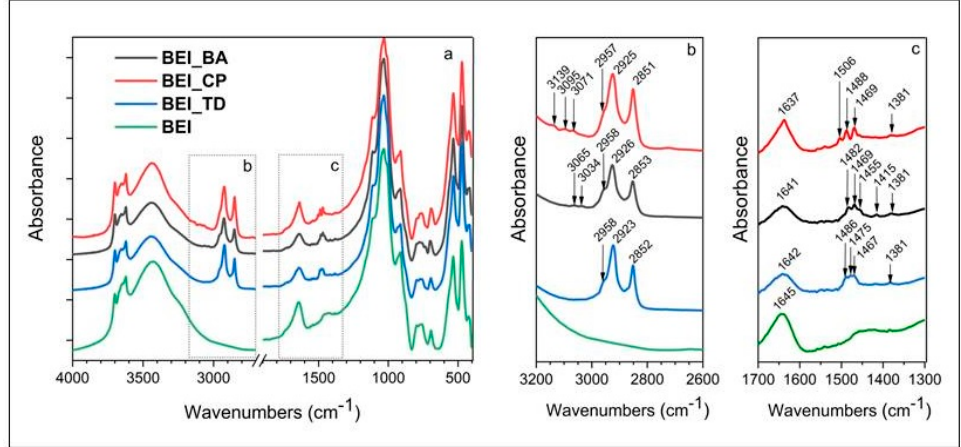
Figure 6. IR spectra of BEI_BA, BEI_CP, BEI_TD and BEI: ( a ) in the whole middle IR area, ( b ) from 3200–2600 cm − 1 and ( c ) from 3200–2600 cm − 1. 3200–2600 cm − 1 and ( c ) from 3200–2600 cm −